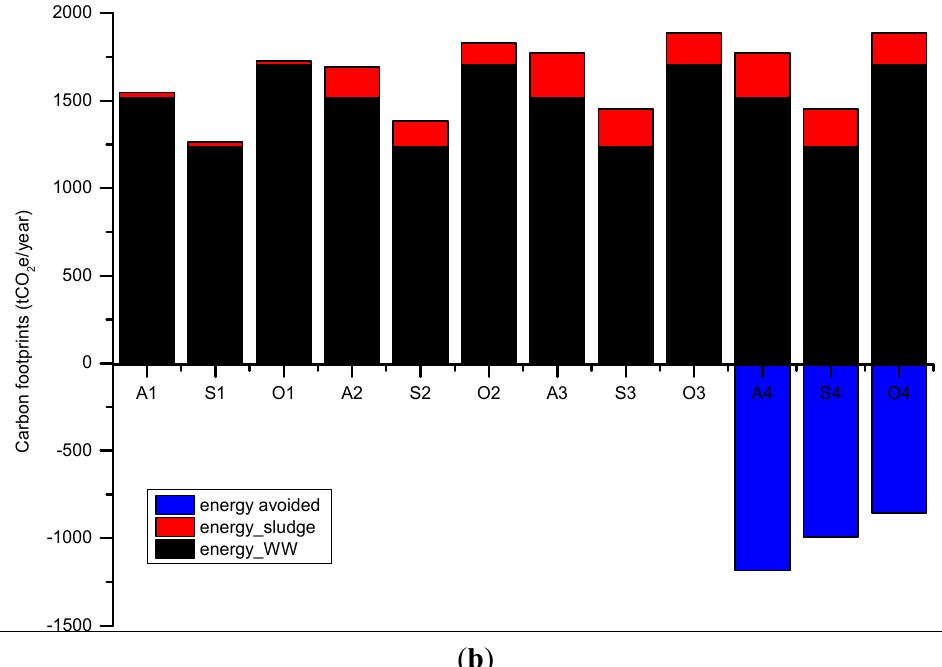
Figure 4. The most important contributors to carbon footprint: ( a ) Direct emissions from wastewater treatment and sludge treatment; and ( b ) Indirect emissions from energy consumption (electricity and transport fuels) in wastewater treatment and sludge